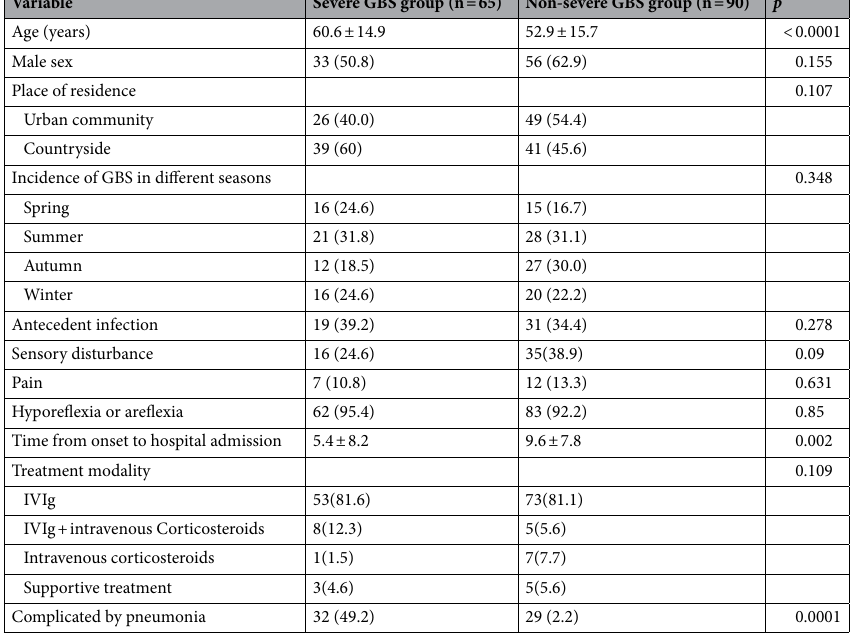
Table 2. Comparison of clinical characteristics and presentation of GBS between severe GBS and non-severe GBS groups. GBS: Guillain-Barré syndrome; IVIg: Intravenous